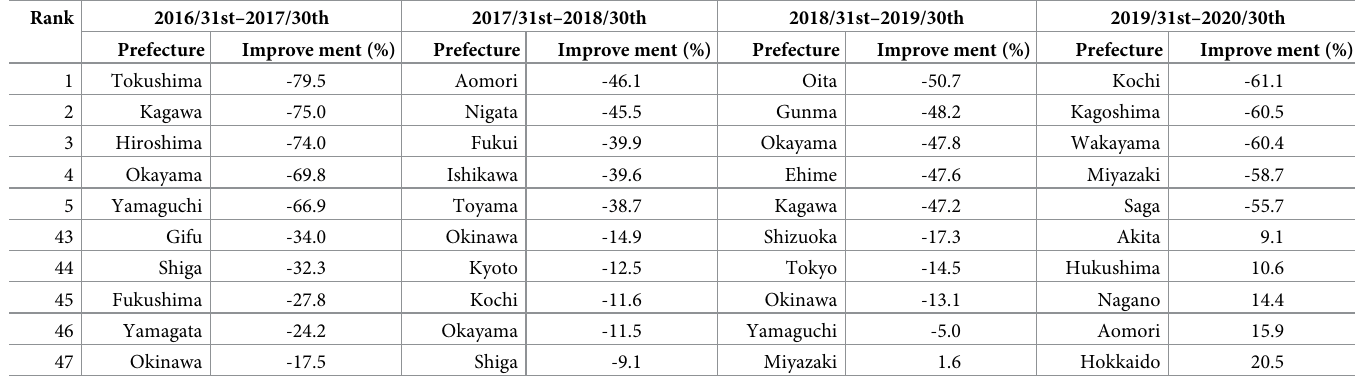
Table 3. Improvement percentage of our predictive performance compared with LSTM in terms of MAE in the five most and least improved prefectures. Lower val- ues indicate greater improvement because a lower MAE indicates better performance.